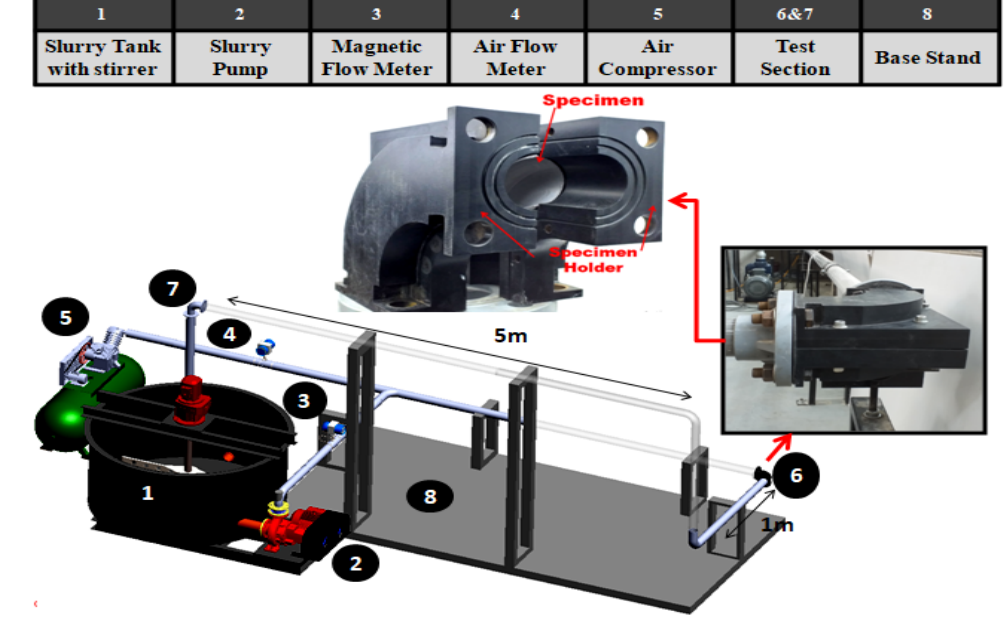
Figure 4. The experimental setup used for the present investigation. Table 2. Silica Sand (wt. Table 1. Elbow material (wt. %).